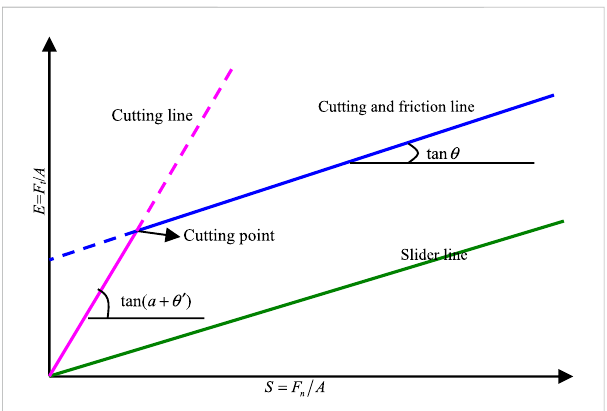
FIGURE 2 Synthetic model for drilling (modi fi ed from Dagrain, 2001). Note: the x-coordinate S is the special energy, and the y-coordinate E is the drilling intensity. S is obtained by dividing the torque force by the force-bearing area, and the ratio of the thrust to the force- bearing area is E